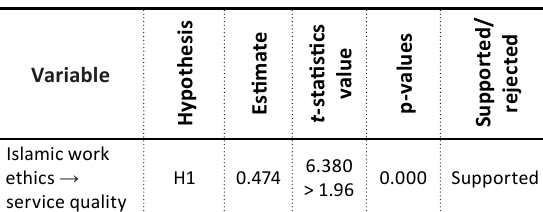
Table 1. Path coefficient for Islamic work ethics and service quality